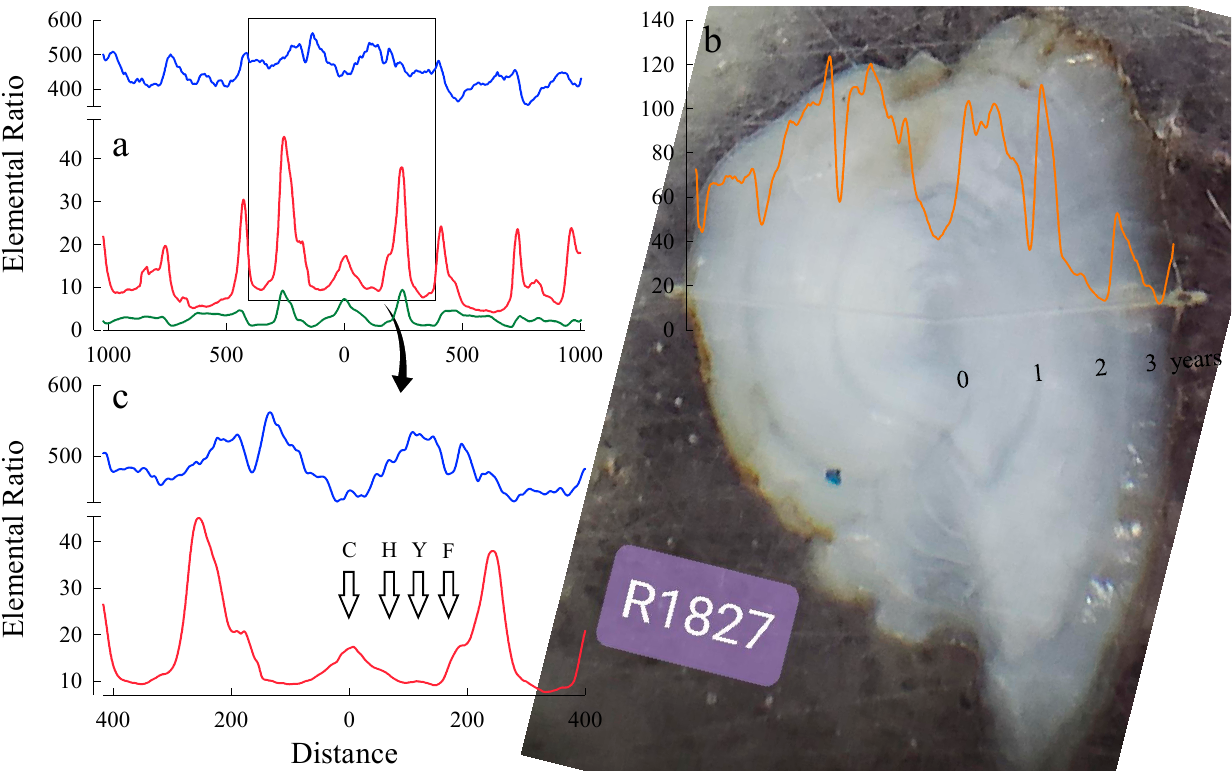
Figure 3. Elemental signatures for an otolith from an adult Kokanee spawner collected in Russell Creek (22.5 cm [L F ] and 99.8 g [M]) on 19 September 2018: ( a ) Elemental signatures from the line scan show changes in Sr (blue), Ba (red), and Mn (green) over the entire life history of the fish; ( b ) Image of otolith showing laser ablation burn to determine elemental composition of the structure. Changes in Zn signatures are superimposed on the image to show how the oscillations align with otolith annuli (photograph courtesy of Jennie Christensen, Trich Analytics, Saanichton, BC, Canada); ( c ) Natal section expanded to show the changes in line scans for Sr (blue) and Ba (red) corresponding to distances defined by [28] from the core on the otolith. The core (C), hatch (H), yolk absorption (Y), and feeding (F) stages for early development stages in Kokanee. Otolith core center is indicated by 0 on the X -axis.